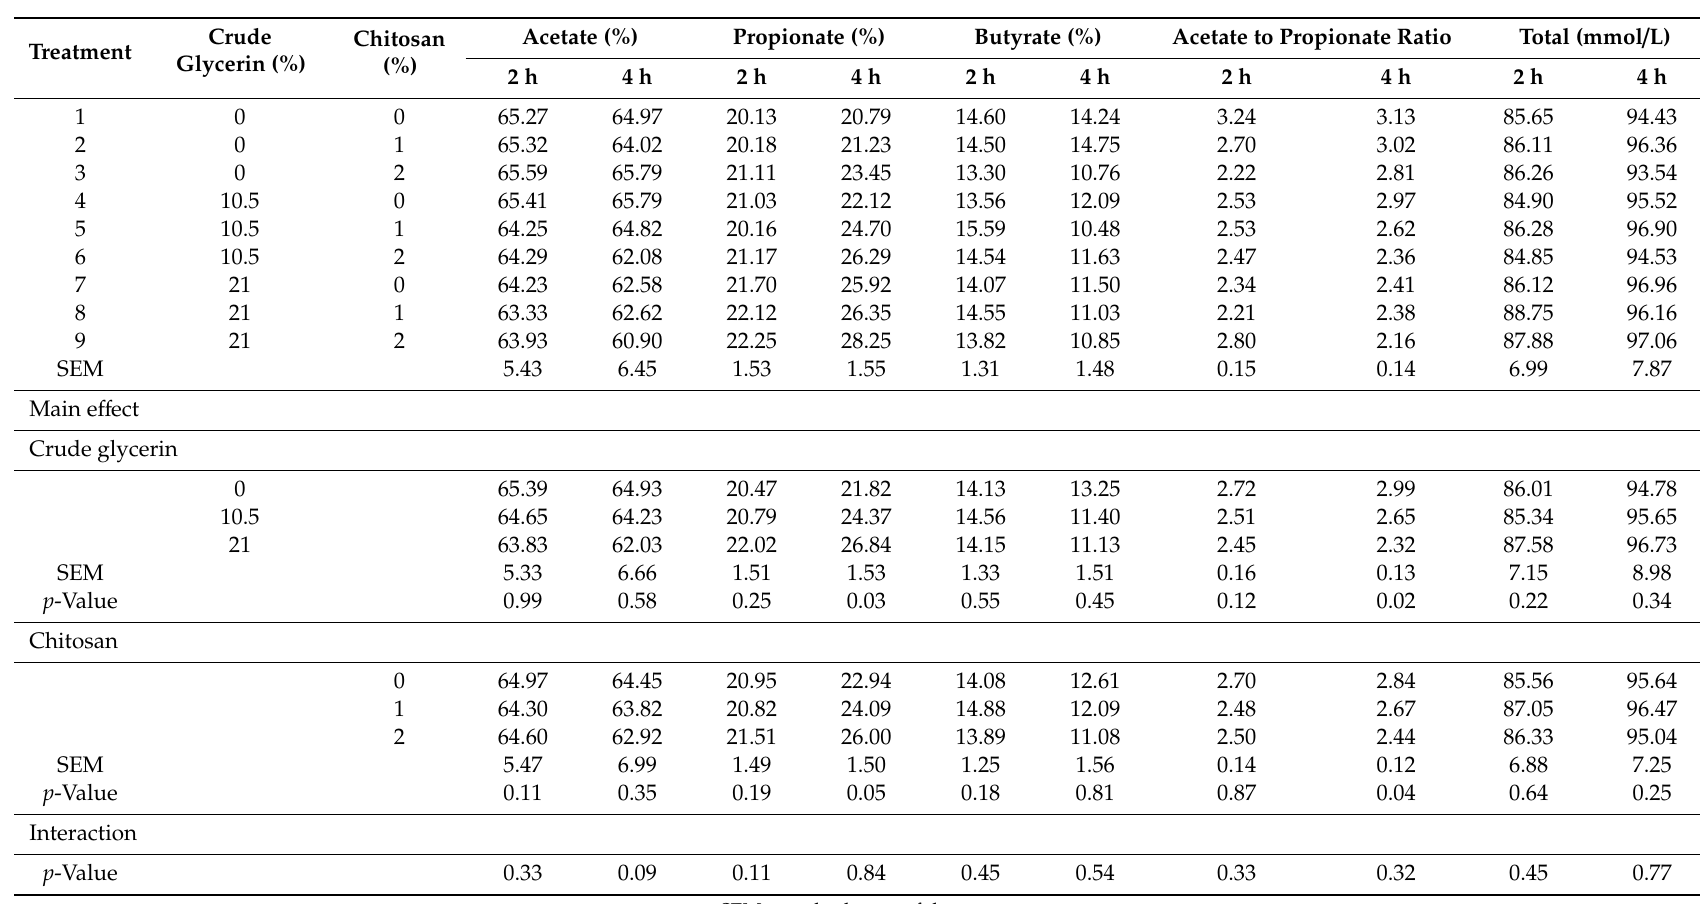
Table 5. Influence of crude glycerin with chitosan on in vitro volatile fatty acids (VFAs) profiles after 2 and 4 h of incubation.